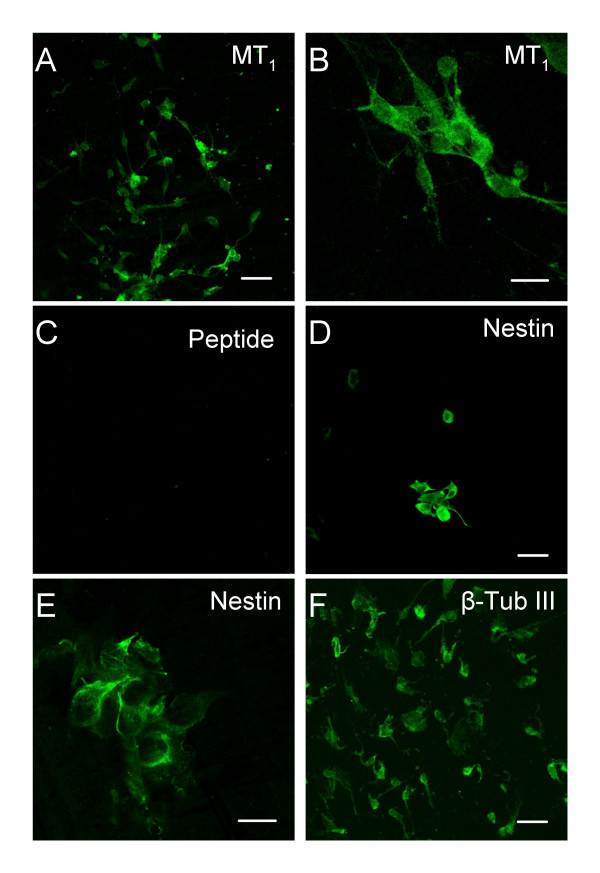
Melatonin MT1 receptor, nestin and β-tubulin III immunoreactivity in C17.2 NSCs. Cells were maintained in 1% FBS for the number of days indicated, except for those shown in panel E, which were cultured in 10% FBS + 5% HS. (A,B) MT1 in cells maintained for 2 days. (C) Peptide (immunogen) blockade of MT1 immunoreactivity after 2 days. (D,E) Nestin immunoreactivity after 2 and 3 days, respectively. (F) β-tubulin III immunoreactivity after 3 days. Scale bars: (A,D,F) 50 μm. (B,E) 20 μm.